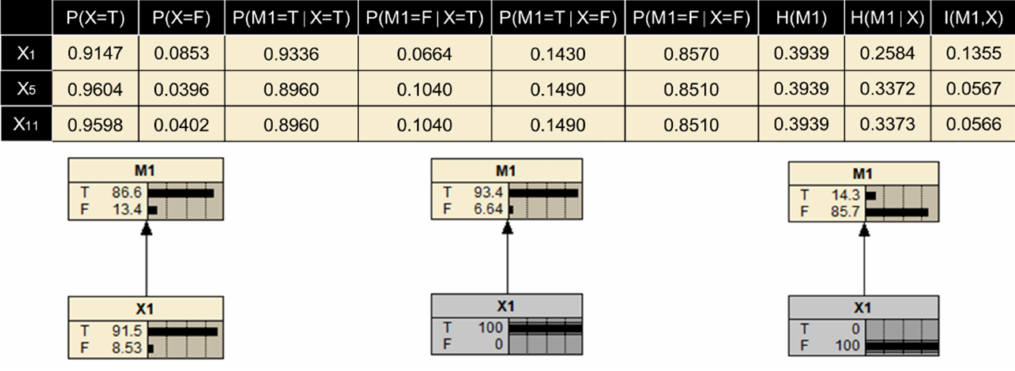
Figure 10. Uncertainty to the target variable under different